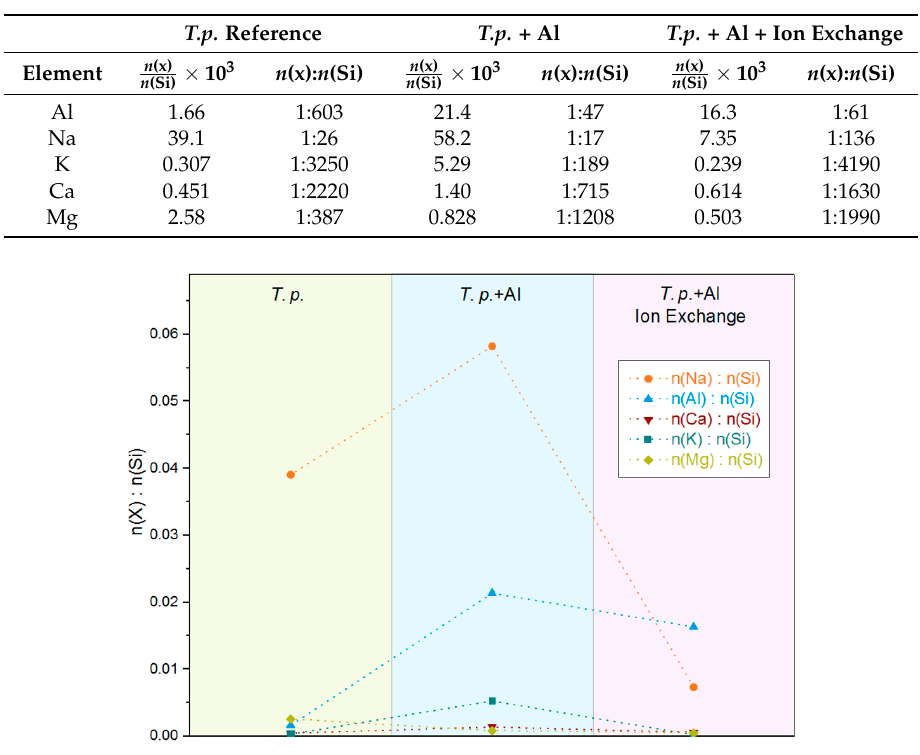
Table 1. Elemental composition of the calcined biosilica as determined by Inductively Coupled Plasma Optical Emission Spectroscopy (ICP-OES).